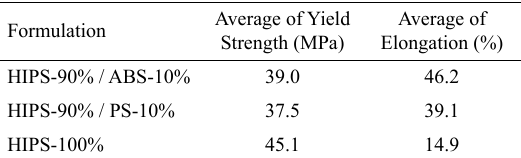
Table 2. Yield strength and elongation values of tensile strength